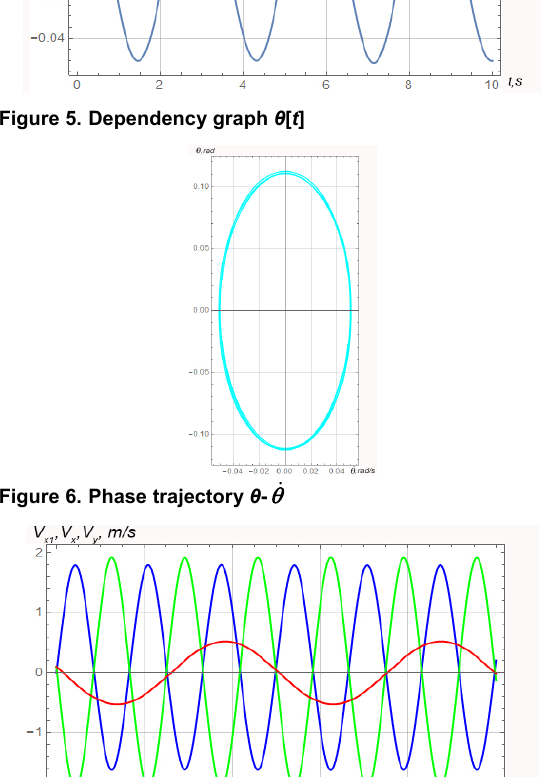
Figure 11. Graph of rope tension